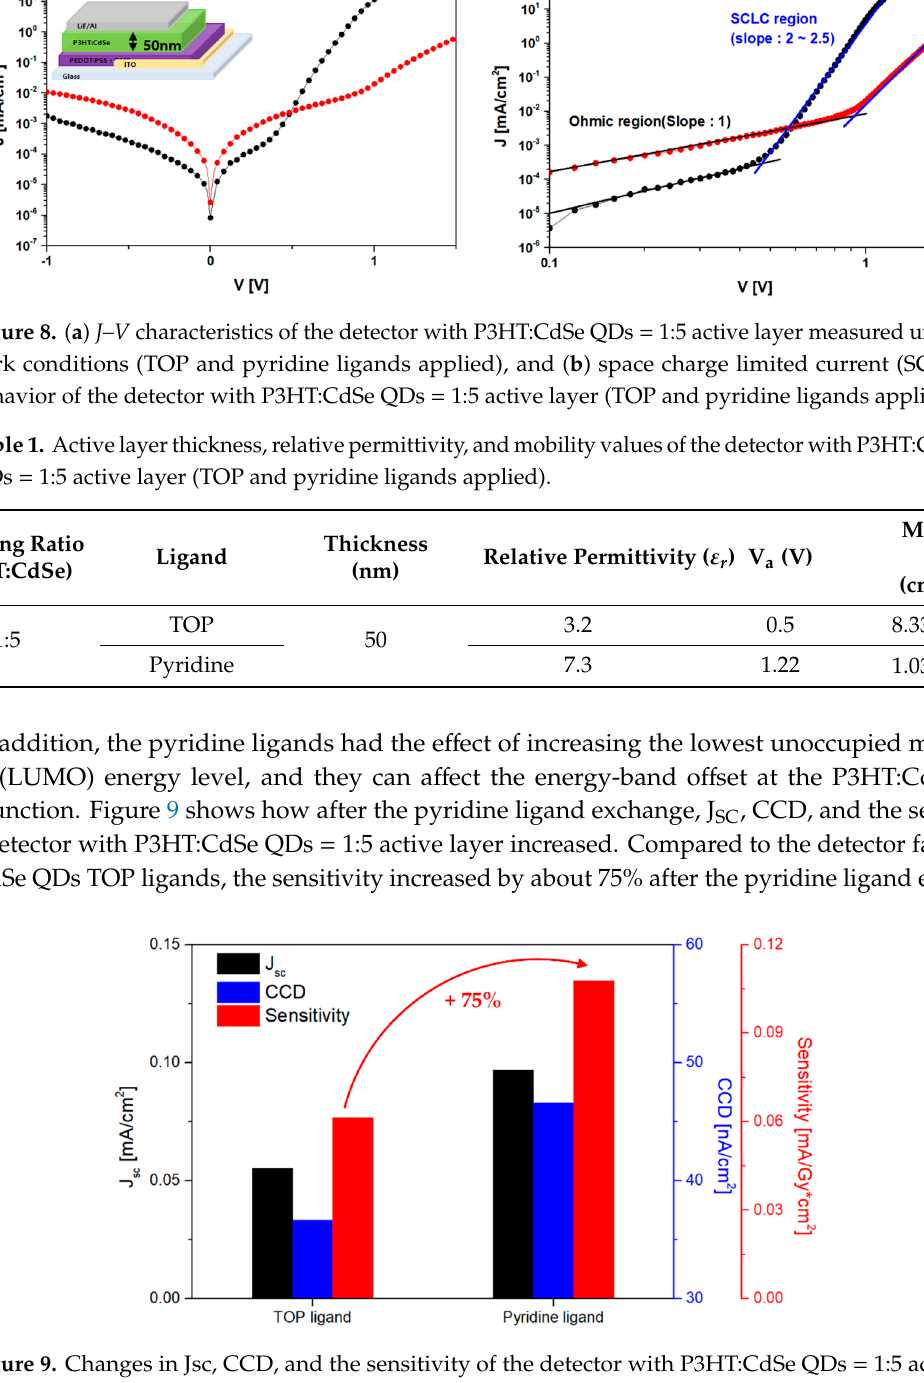
Figure 9. Changes in Jsc, CCD, and the sensitivity of the detector with P3HT:CdSe QDs = 1:5 active layer after ligand exchange.